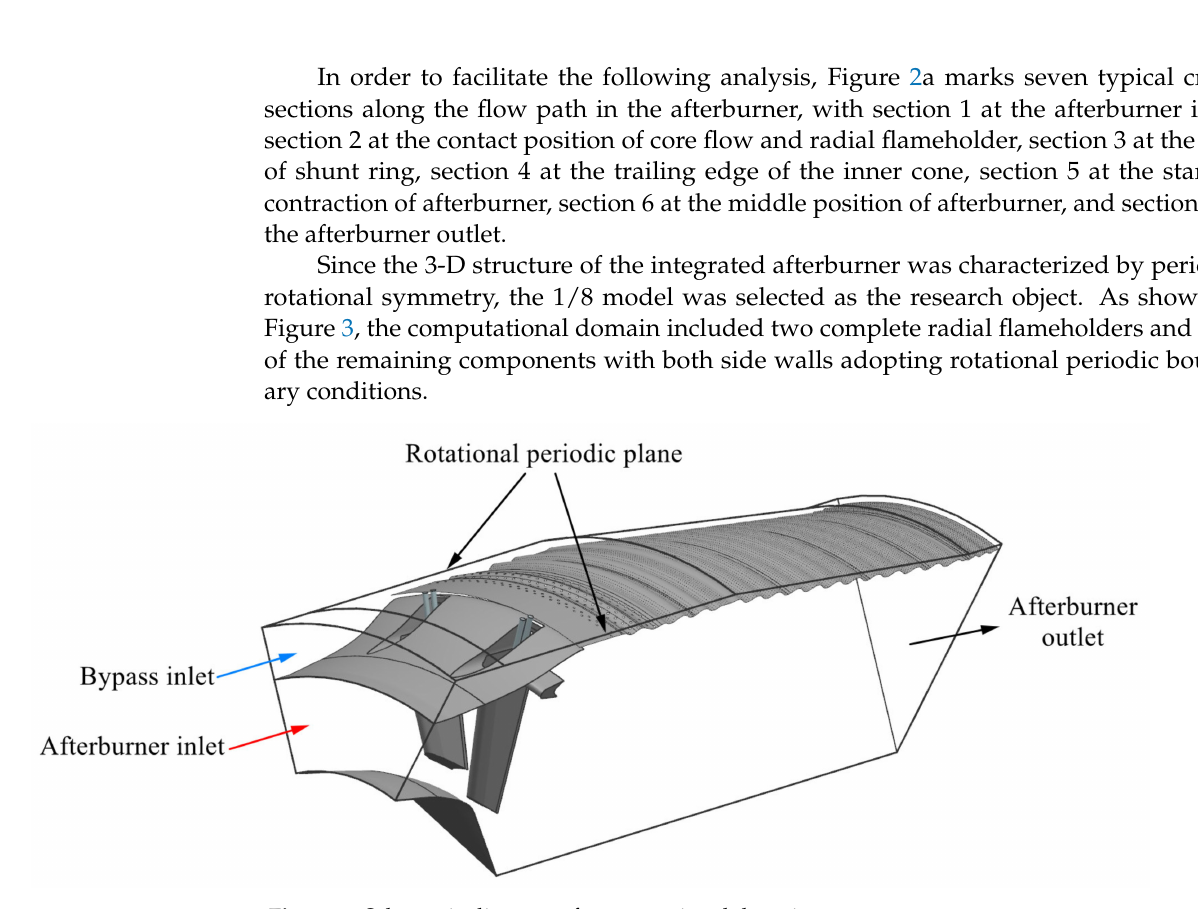
Figure 3. Schematic diagram of computational domain structure.